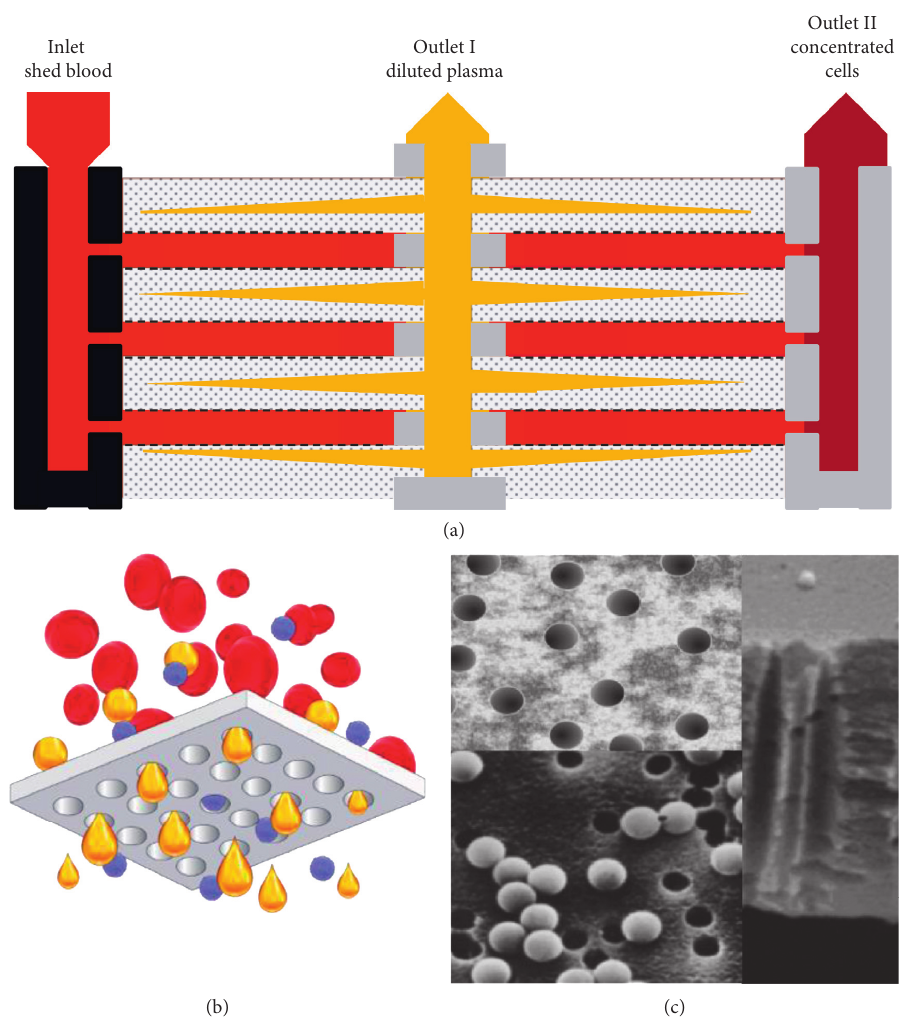
Figure 2: (a) Schematic illustration of the HemoClear multilayer, micropore filtration technology. The filtration module comprises an inlet for the shed blood to enter. Two outlets lead the diluted plasma (outlet I) and concentrated cells (outlet II) to collection bags. The internal design of the membrane yields a cross-flow current of shed blood cells from the inlet to outlet II, preventing blockage of the pores. (b) The pores only allow passage of fluids (yellow) and solutes (blue), while red blood cells remain on top of the filtration layer (grey). (c) Highly accurate nanotechnology is used to achieve pores of exactly 2.3 microns in